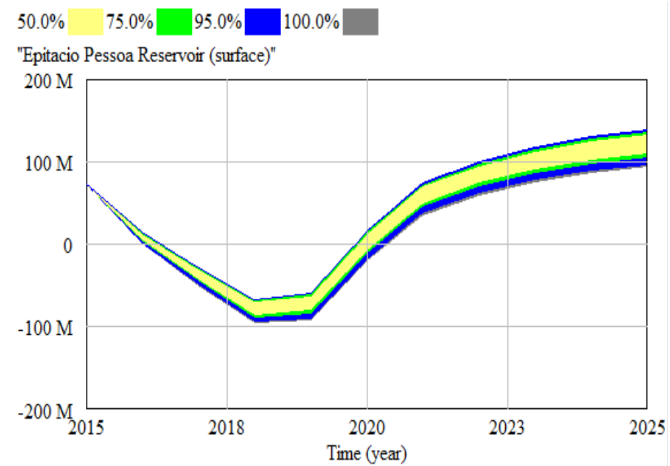
Figure 16. Monte Carlo simulation result for Scarcity-based